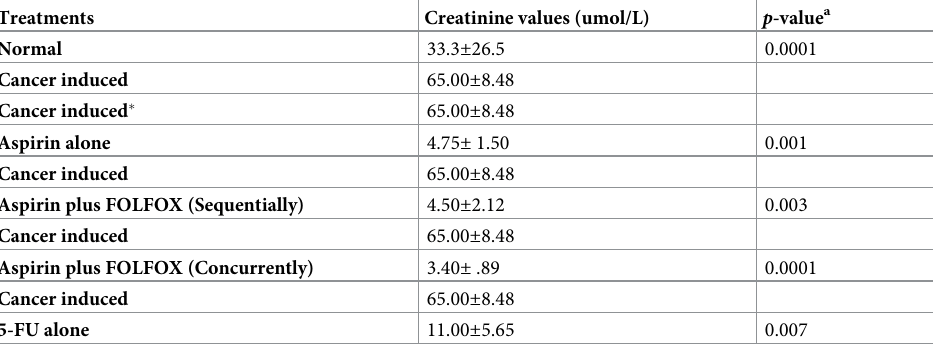
Values are presented as mean ± SD. a The result is significant when p <